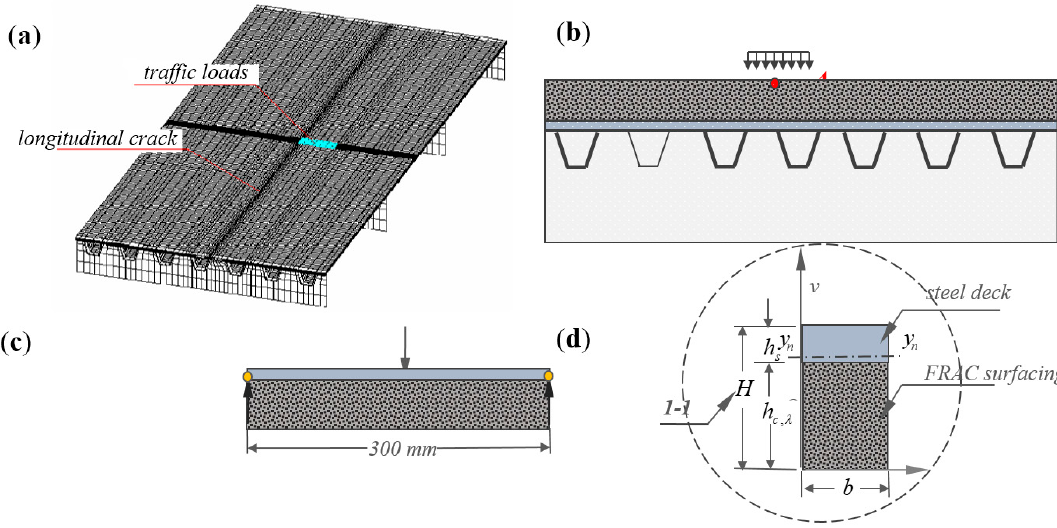
Figure 1. Steel deck fiber-reinforced asphalt concrete (FRAC) surfacing composite beam for fatigue analysis: ( a ) orthotropic local finite element model; ( b ) critical position of the vehicle wheel load; ( c ) composite beam equipment for fatigue testing; ( d ) cross-section of the double-layer composite beam.